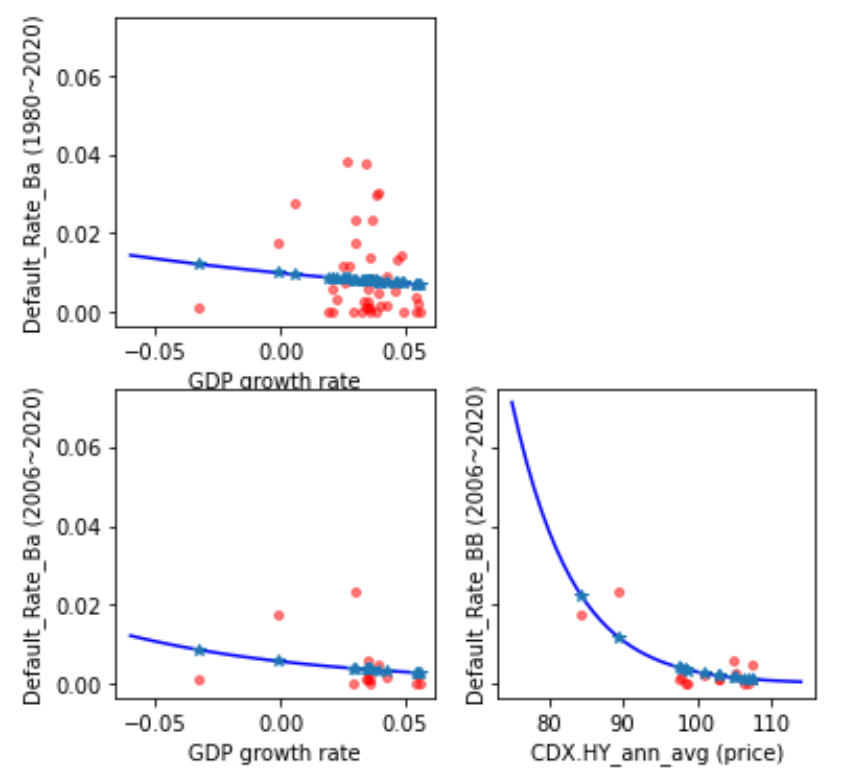
Figure 5. Rating Ba: logistic regression of DR_Ba on ( a ) GDP with 1980–2020 data; ( b ) GDP with 2006–2020 data; ( c ) CDX.HY with 2006–2020 data (in price).